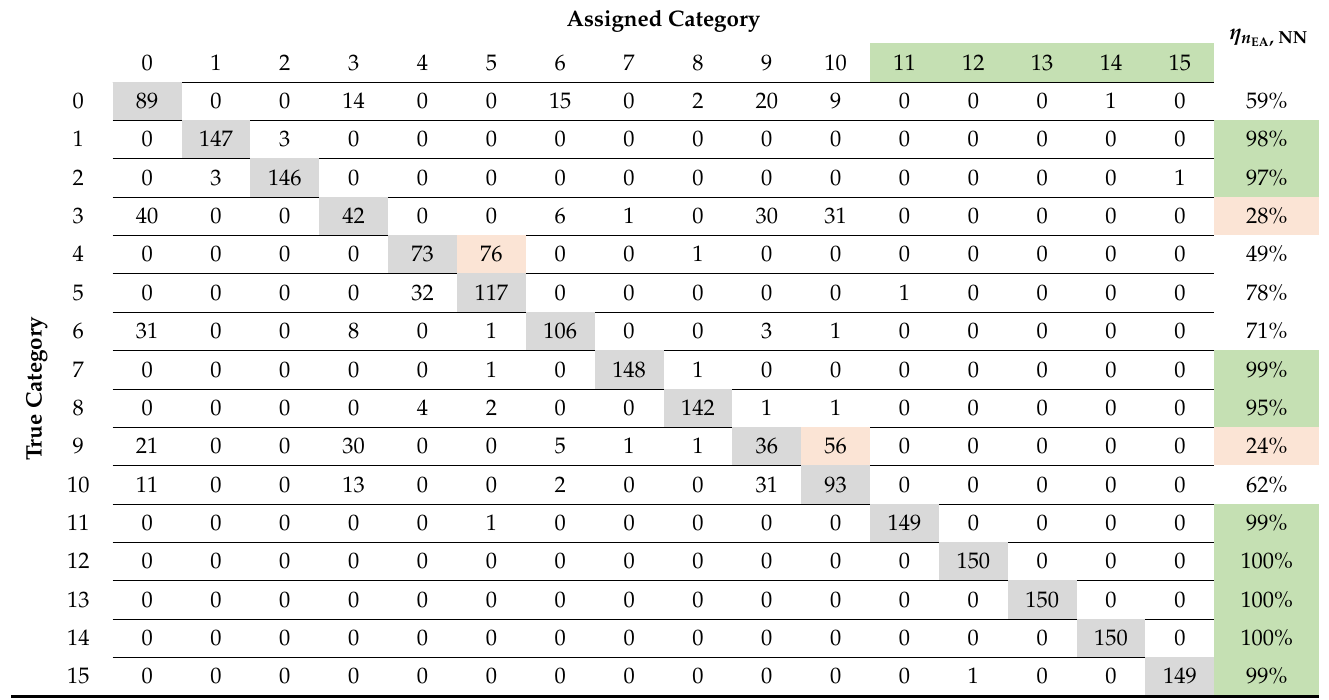
Table 4. Confusion matrix and the classification accuracy of the neural network for 15 neurons in the hidden layer.